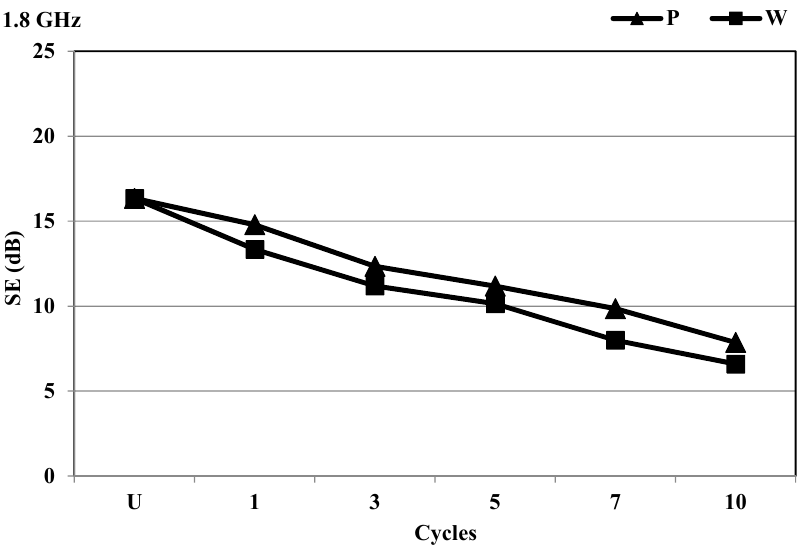
Figure 8. SE of the PA/Ag fabric before and after 10 cycles of treatment with P and W at the frequency of 1.8 GHz.